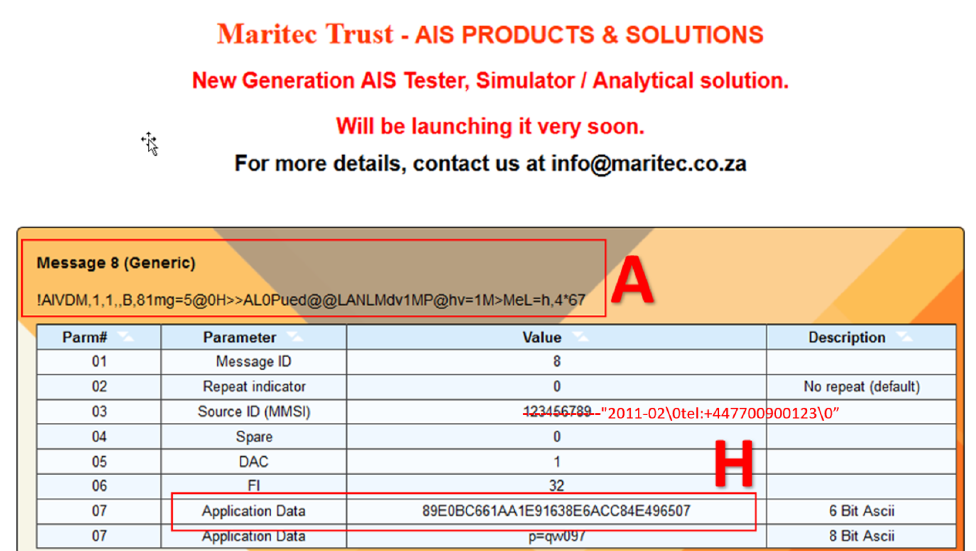
Figure 14. Cryptographic value H ( H ) on the application data section of the conventional ID8 AIS message ( A